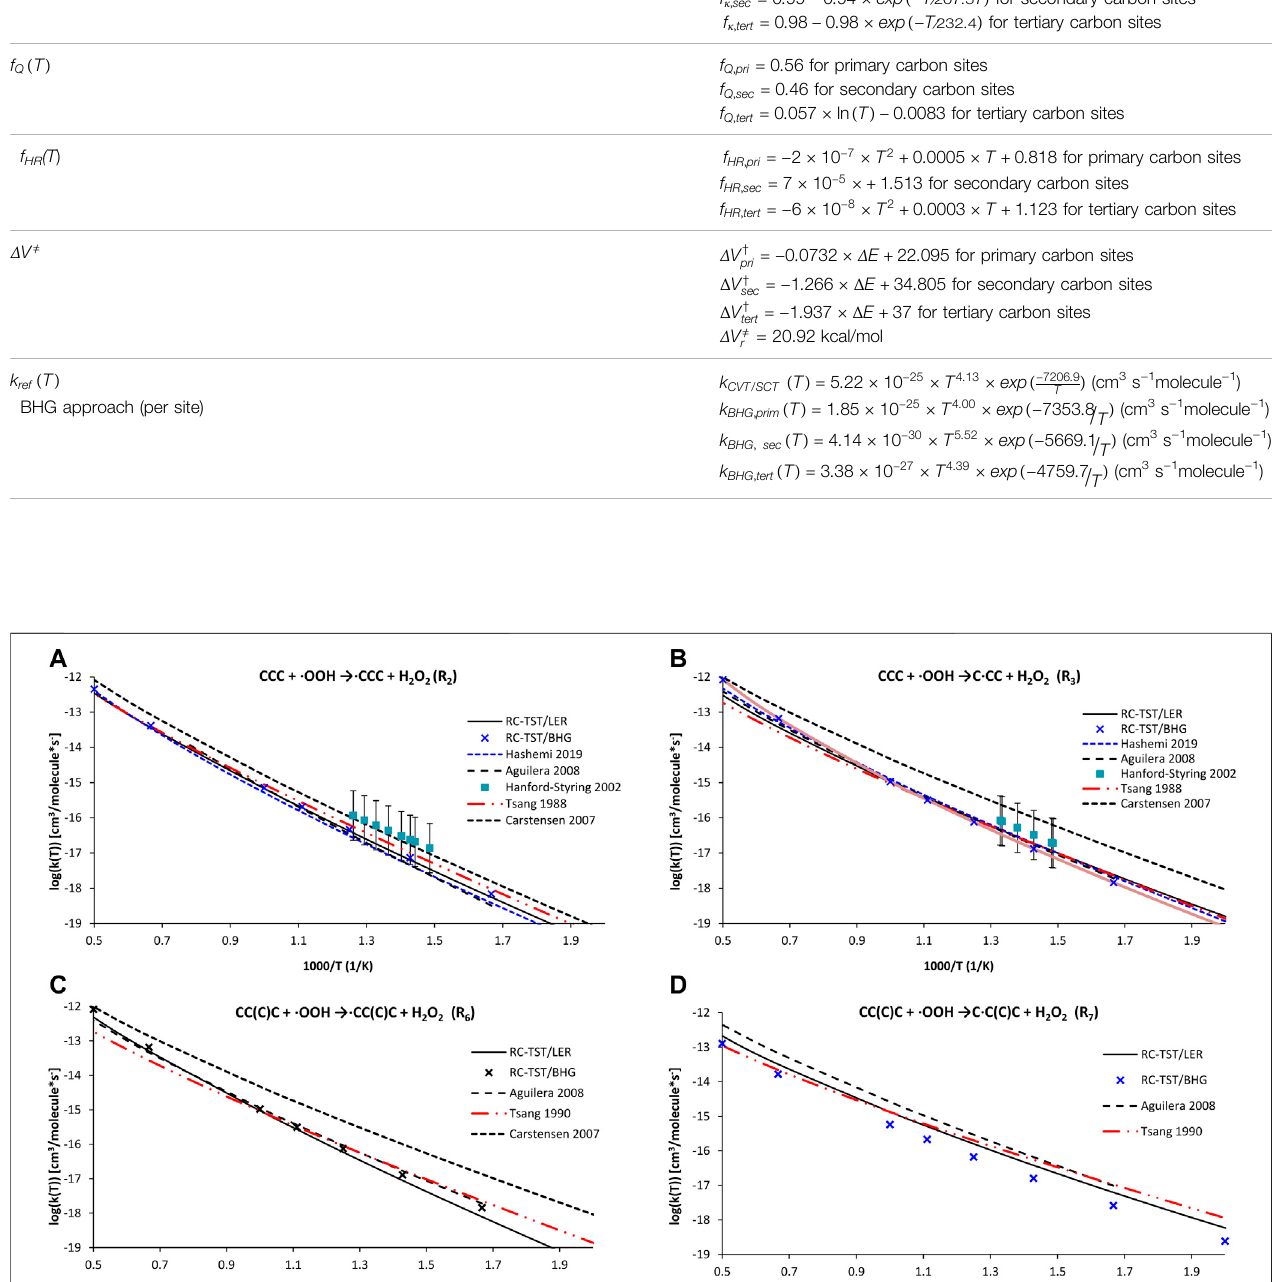
Frontiers in Chemistry |